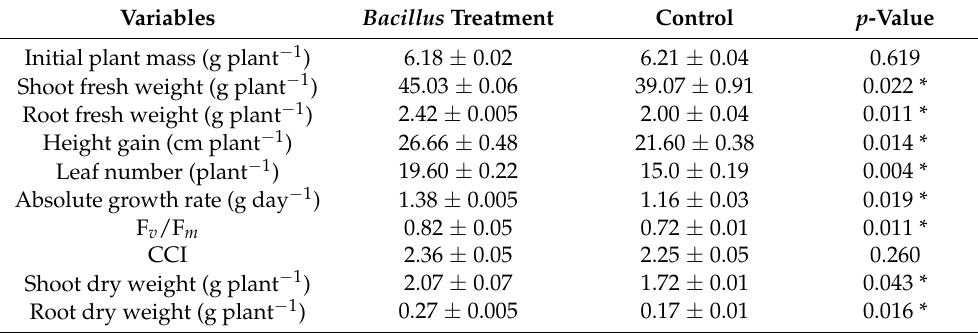
Table 1. Vegetative growth and chlorophyll fluorescence of ‘Locarno’ lettuce cultivar grown in aquaponic systems treated with a Bacillus probiotic. Significant differences between Bacillus treated and control systems ( p < 0.05) are marked by an asterisk. Data are means ± standard error (SE). Variables Bacillus Treatment Control p